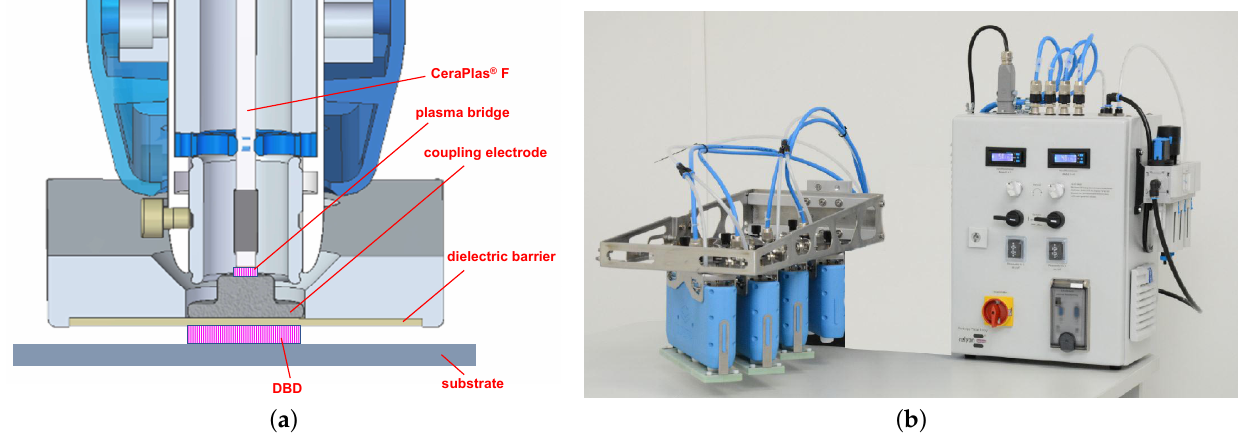
Figure 8. The modular treatment unit with 12 CeraPlas™F plasma sources organized in 4 sub-units and the power and gas control unit. ( a ) Plasma generation principle. ( b ) Picture of the